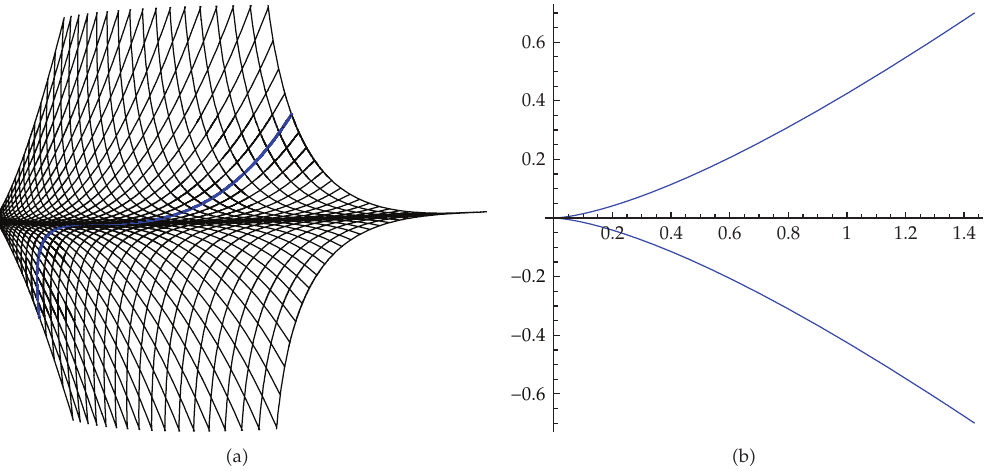
Figure 8: A spacelike surface obtained by isotropic rotations parametrized by the Tchebychev net and the projection of a parametric curve onto yz